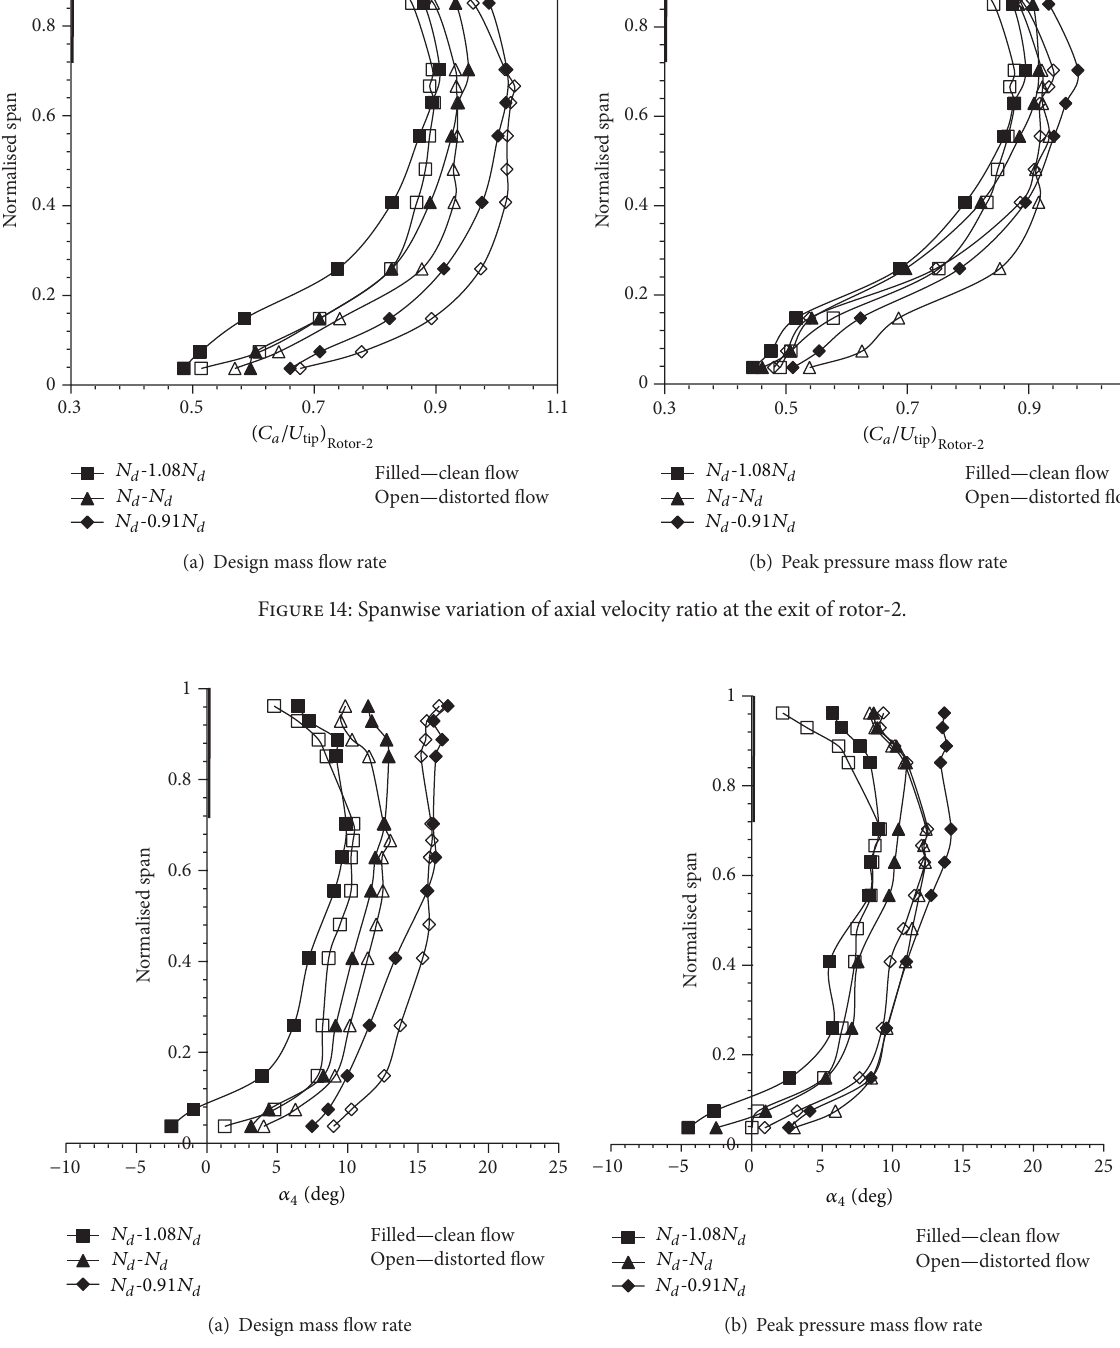
Figure 15: Spanwise variation of flow angle at the exit of